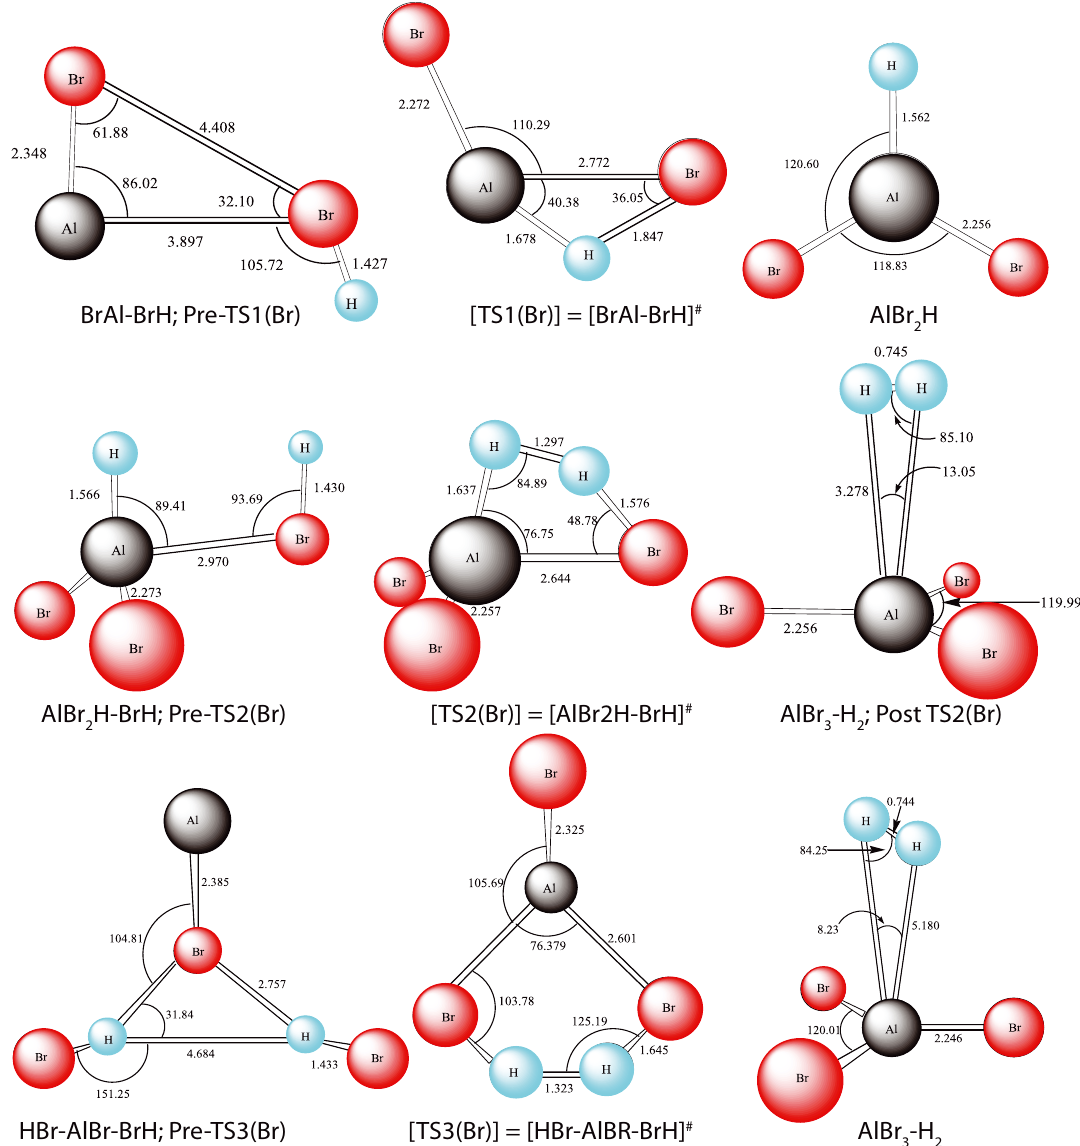
Figure 1. Optimized geometries for X = Br. All species are Cs symmetry. Bond lengths are in Å and bond angles in